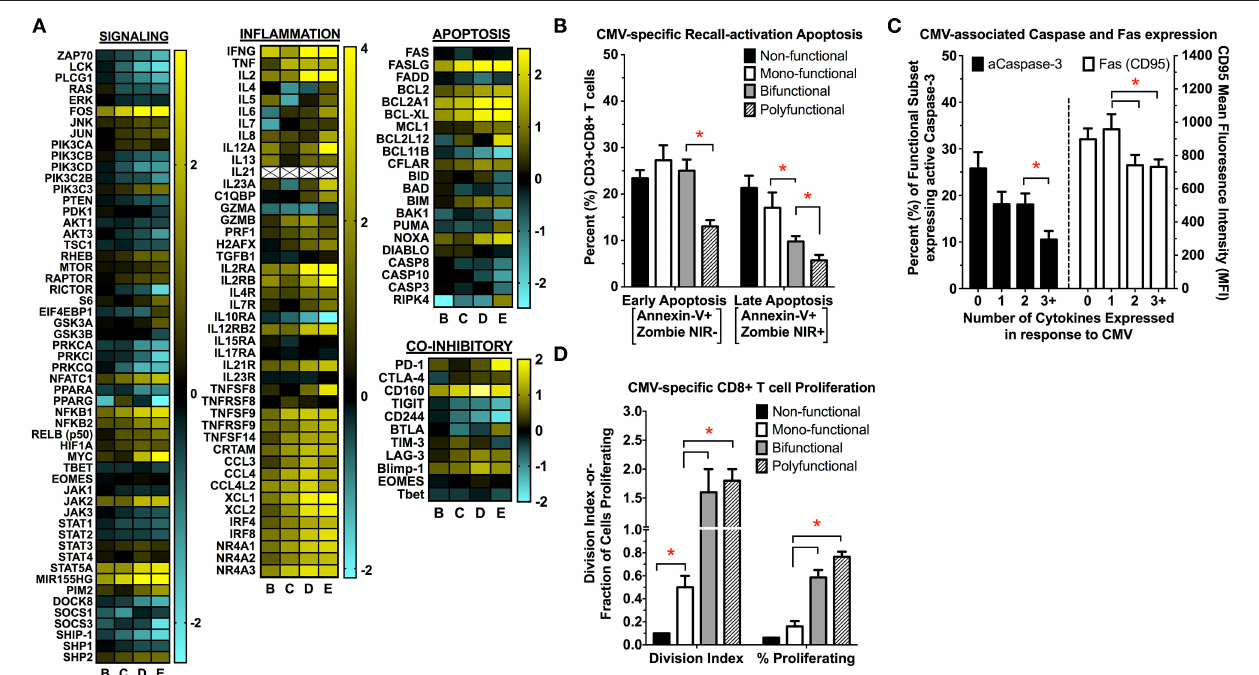
FIGURE 4 | (A) Changes in cellular signaling, inflammation, apoptosis/cell survival, and co-inhibitory receptor transcript expression between the functional subsets of CMV-specific CD8 + T cells. First, genes differentially expressed between the functional subsets of CMV-specific CD8 + T cells were identified using DESeq2. This list of differentially expressed genes was then used for further in silico analysis, which identified multiple KEGG signaling pathways that were significantly upregulated in polyfunctional vs. mono- or non-functional T cells. This identified pathways involved in TCR- and cytokine-mediated signaling, viral response, inflammation, apoptosis/cell survival, and metabolism. Genes involved in these significantly-regulated pathways were then used to generate the heatmaps shown in ( A ) to highlight specific transcriptional patterns across the subsets ( n = 5). All values are shown as log 2 fold-change relative to the non-functional T cell population ( pop A ). The changes in inflammatory signaling seen in polyfunctional T cells is consistent with prior studies examining antigen-specific polyfunctional T cells, identified by the expression of IFN γ alone, without further functional sub-setting to specifically examining polyfunctional cells (65–68). These conserved pathways include tumor necrosis factor receptor (TNFR) signaling, effector/cytokine expression (e.g., GZMB), chemokine signaling (e.g., XCL1/2), and NR4A nuclear receptor family signaling. (B–D) Determination of CMV-specific CD8 + T cell re-activation induced apoptosis (B) , expression of caspase-3 and FAS (CD95) (C) , and proliferation (D ) following antigen re-challenge ( n = 5; error bars represent SEM). Apoptosis (early and late), caspase-3, and Fas are expressed as the percentage (%) of the parent population (functional subset), whereas proliferation is expressed as the division index (DI) and the percent (%) parent population. Statistical testing: * p < 0.05. Populations: (A) non-functional (IFN γ -/TNF α -/IL-2-); (B) IFN γ only/monofunctional (IFN γ + /TNF α -/IL-2-); (C) TNF α monofunctional (IFN γ -/TNF α + /IL-2-); (D) bifunctional (IFN γ + /TNF α + /IL-2-); and (E) polyfunctional (IFN γ + /TNF α + /IL-2 +